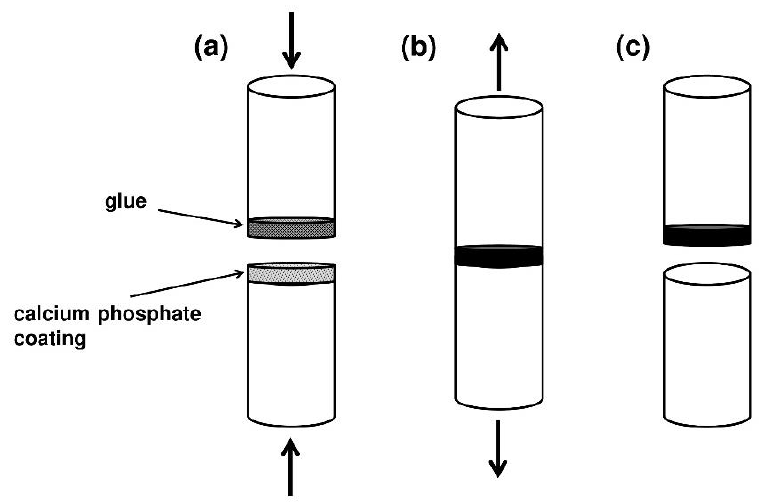
Figure 14. Sketch of the standardized measurement of tensile adhesion.